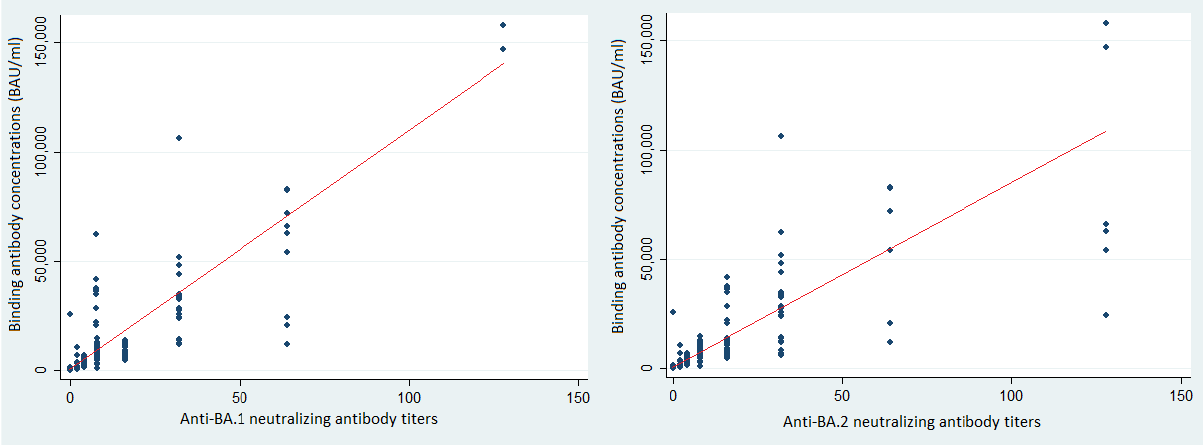
Figure 3. Binding antibody concentrations according to BA.1 and BA.2 neutralizing antibody titers among infected/vaccinated HCWs and trend curve (red line).